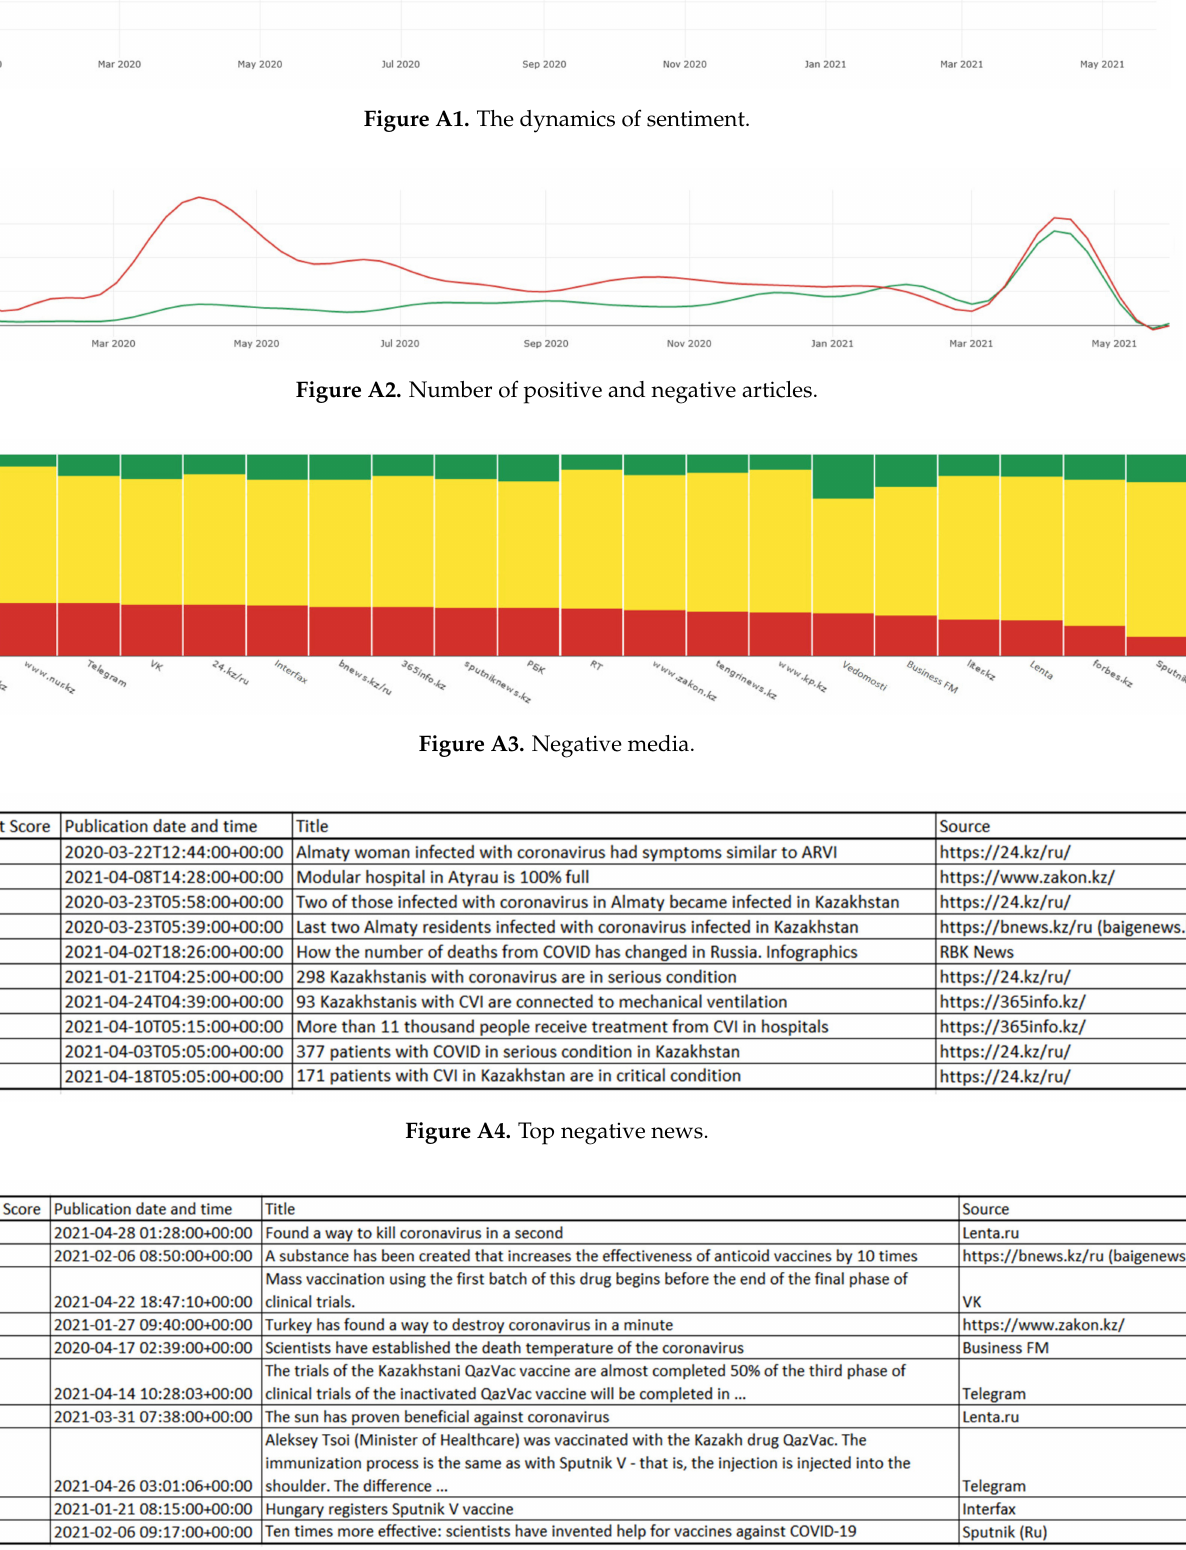
Figure A5. Top positive